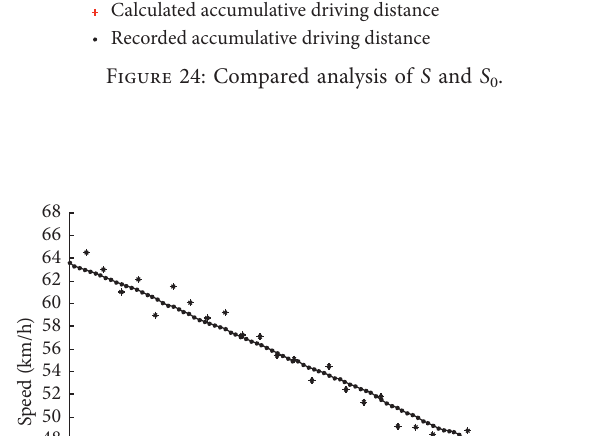
Figure 24: Compared analysis of S and S